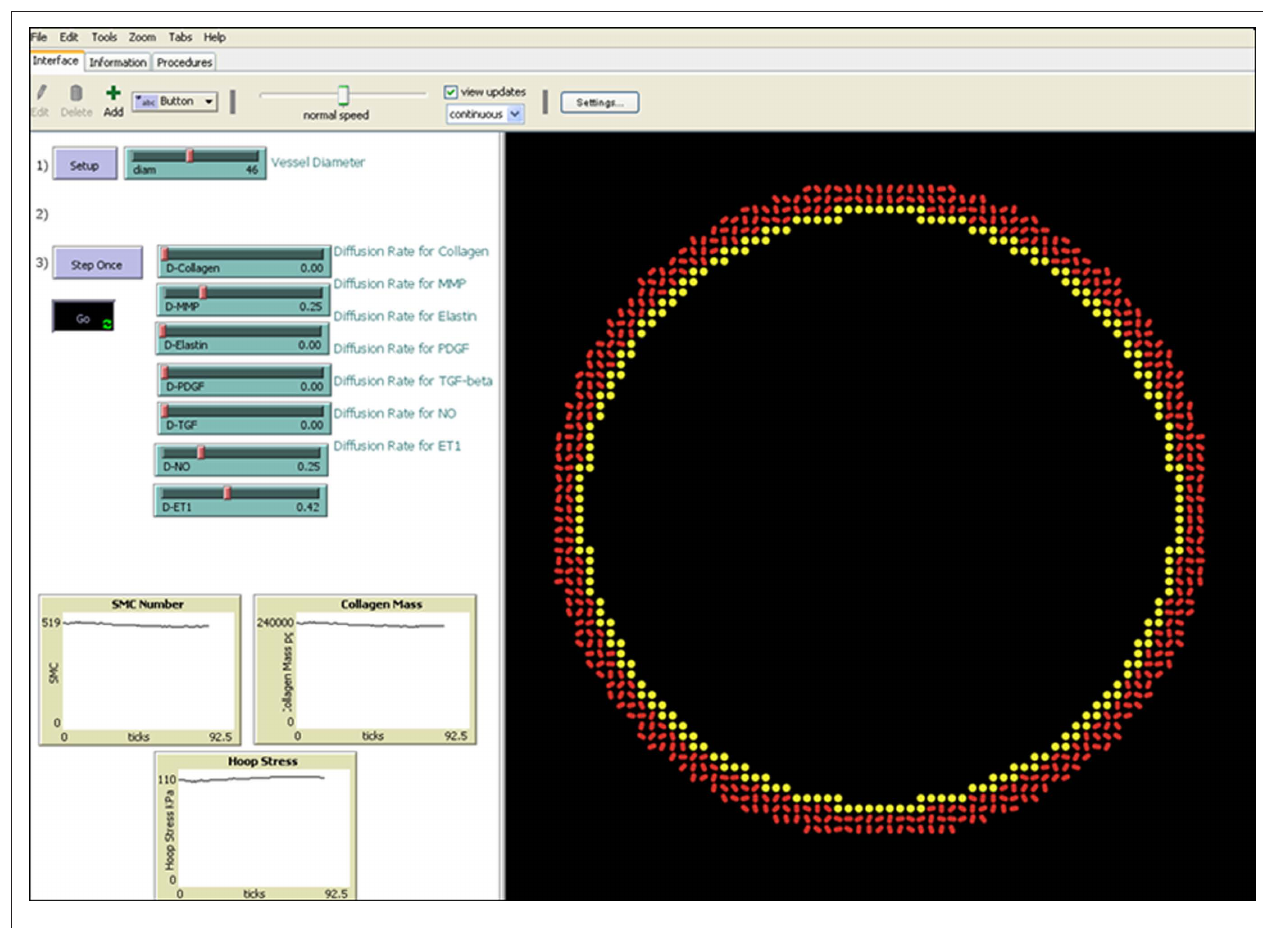
Figure 1 | Screen shot of the ABM during a homeostatic run, displaying a 2-D representation of a transverse section of the model mouse abdominal aorta on the right and user controls as well as a display of progress on the left. Inner diameter of the vessel is 460